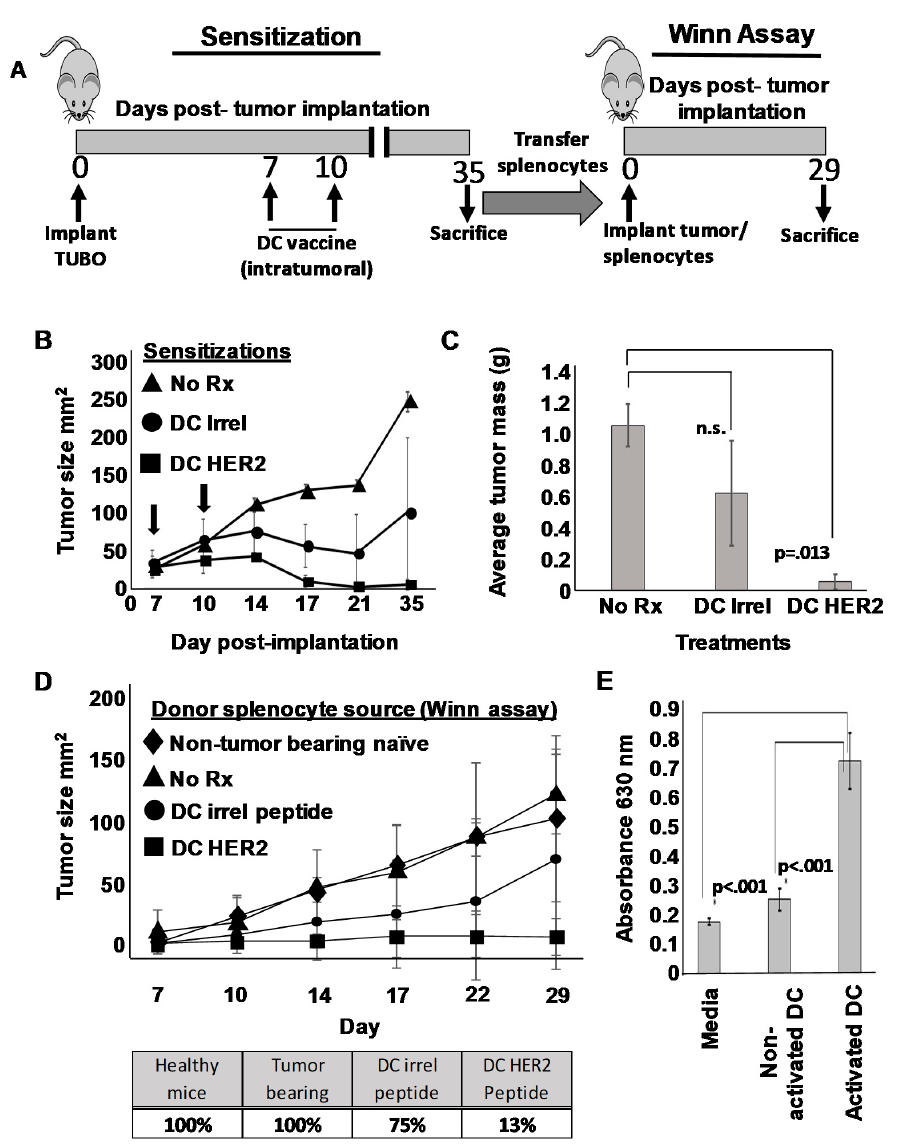
Figure 4. DCs possess a discrete anti-tumor activity that is not dependent on loading with tumor-associated antigen. ( A ) Schema of treatment protocol. On day 0, 15 female Balb/c mice were implanted orthotopically with 1 × 10 6 TUBO breast carcinoma cells. On day 7, mice were divided into three groups of five each and received via intratumoral administration 1 × 10 6 SFM-DCs pulsed with either rat Erb/B2/HER2 class I peptide, TYVPANSL (DC HER2) or irrelevant peptide (DC Irrel). The third group was left untreated (No Rx). On day 10 mice received a second, identical inoculation. Tumor size was measured twice weekly until day 35, when all mice were sacrificed, pooled splenocytes from each of the three groups were admixed with cultured TUBO cells, and in a Winn-type assay, injected orthotopically into fresh naïve mice. A fourth control group with TUBOs combined with naïve mouse spleens was also included. Tumor growth was measured twice weekly, and all mice were sacrificed 29 days after tumor implantation. ( B ) Tumor growth curves (sensitization phase) for the three treatment groups. Arrows indicate the two intratumoral DC vaccinations. ( C ) Average mass of tumors excised from sacrificed mice on day 35 for each treatment group. ( D ) Tumor growth curves (upper panel) from the Winn-type assay. Percentage of mice (lower panel) that developed tumors in Winn assay. ( E ) Culture supernatants from DCs either treated with ODN1826 and LPS (activated DC) or not (Non-activated DC) were removed 24 h later and added at a 1:1 ratio with cultured TUBO cells. After 72 h Alamar Blue dye was added and optical density of supernatants determined several hours later at 630